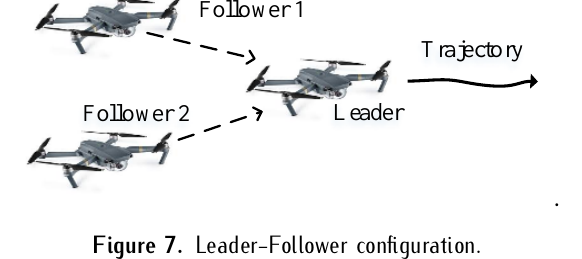
Figure 7. Leader-Follower configuration.